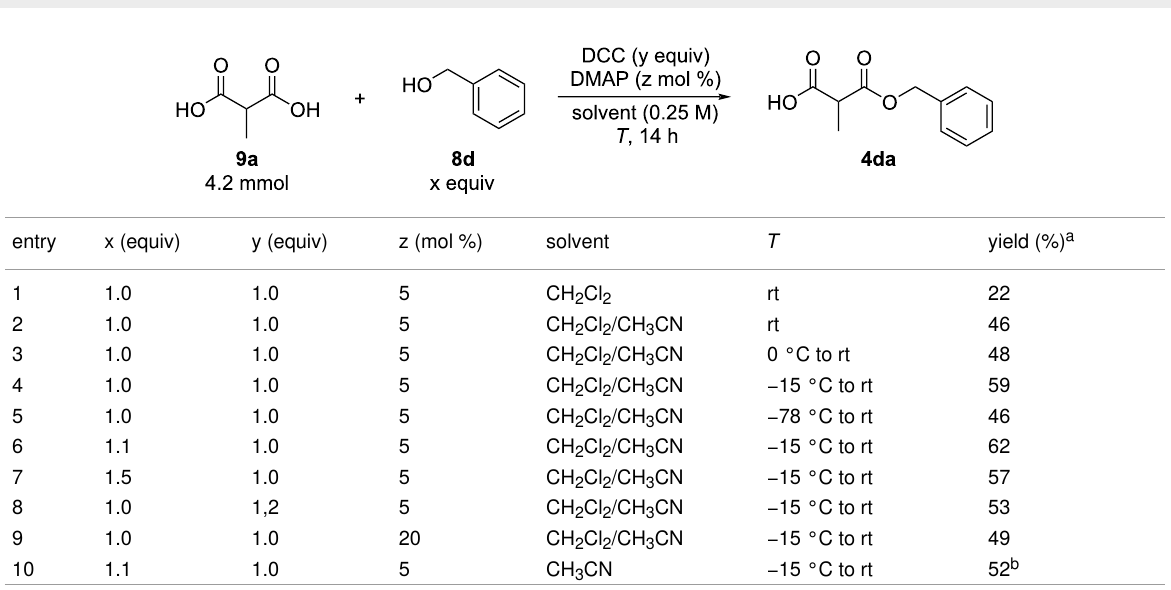
Table 4: Optimization of the mono-esterification of malonic acid 10a